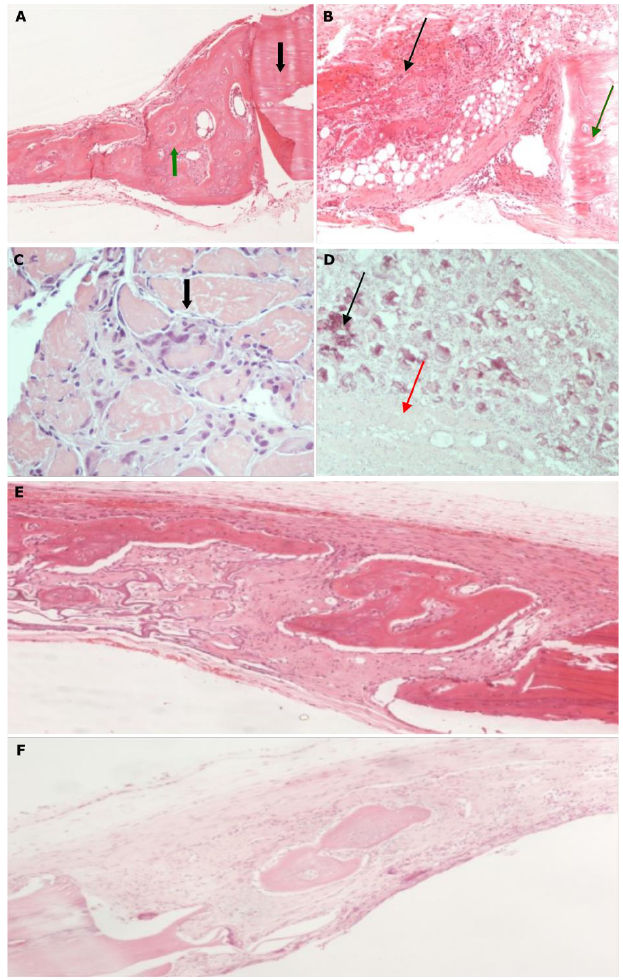
Figure 7. Histological micrographs of groups STDS and STDL. ( A ) Group STDS1, magnification 200 × : microscopic image of bone tissue with abundant new bone formation (green arrow) broadly thick and in triangular shape (triangle base in contact with the defect margins (black arrow) and triangle apex towards the center of the defect); ( B ) Group STDS2, magnification 200 × : extended degradation (black arrow) can be seen at the defect’s margins (green arrow) and adipose tissue formation (red arrow); ( C ) Group STDS1, magnification 100 × : microscopic image of quadriceps muscle with extensive necrosis. Foreign body-type multinucleated giant cells are observed (black arrow); ( D ) Group STDS2, magnification 100 × : microscopic image of quadriceps muscle with marked Ca ++ deposition (black arrow) and extensive fibrosis (red arrow); ( E ) Group STDL2, magnification 20 × : new osseous tissue develops, while the membrane has been degraded to a significant extent and replaced by fibrous connective tissue; ( F ) Group STDL3, magnification 20 × : the new osseous tissue remains constant after 4 weeks, while the fibrous connective tissue is